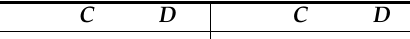
Table 1. Utilities for PD (left) and SG